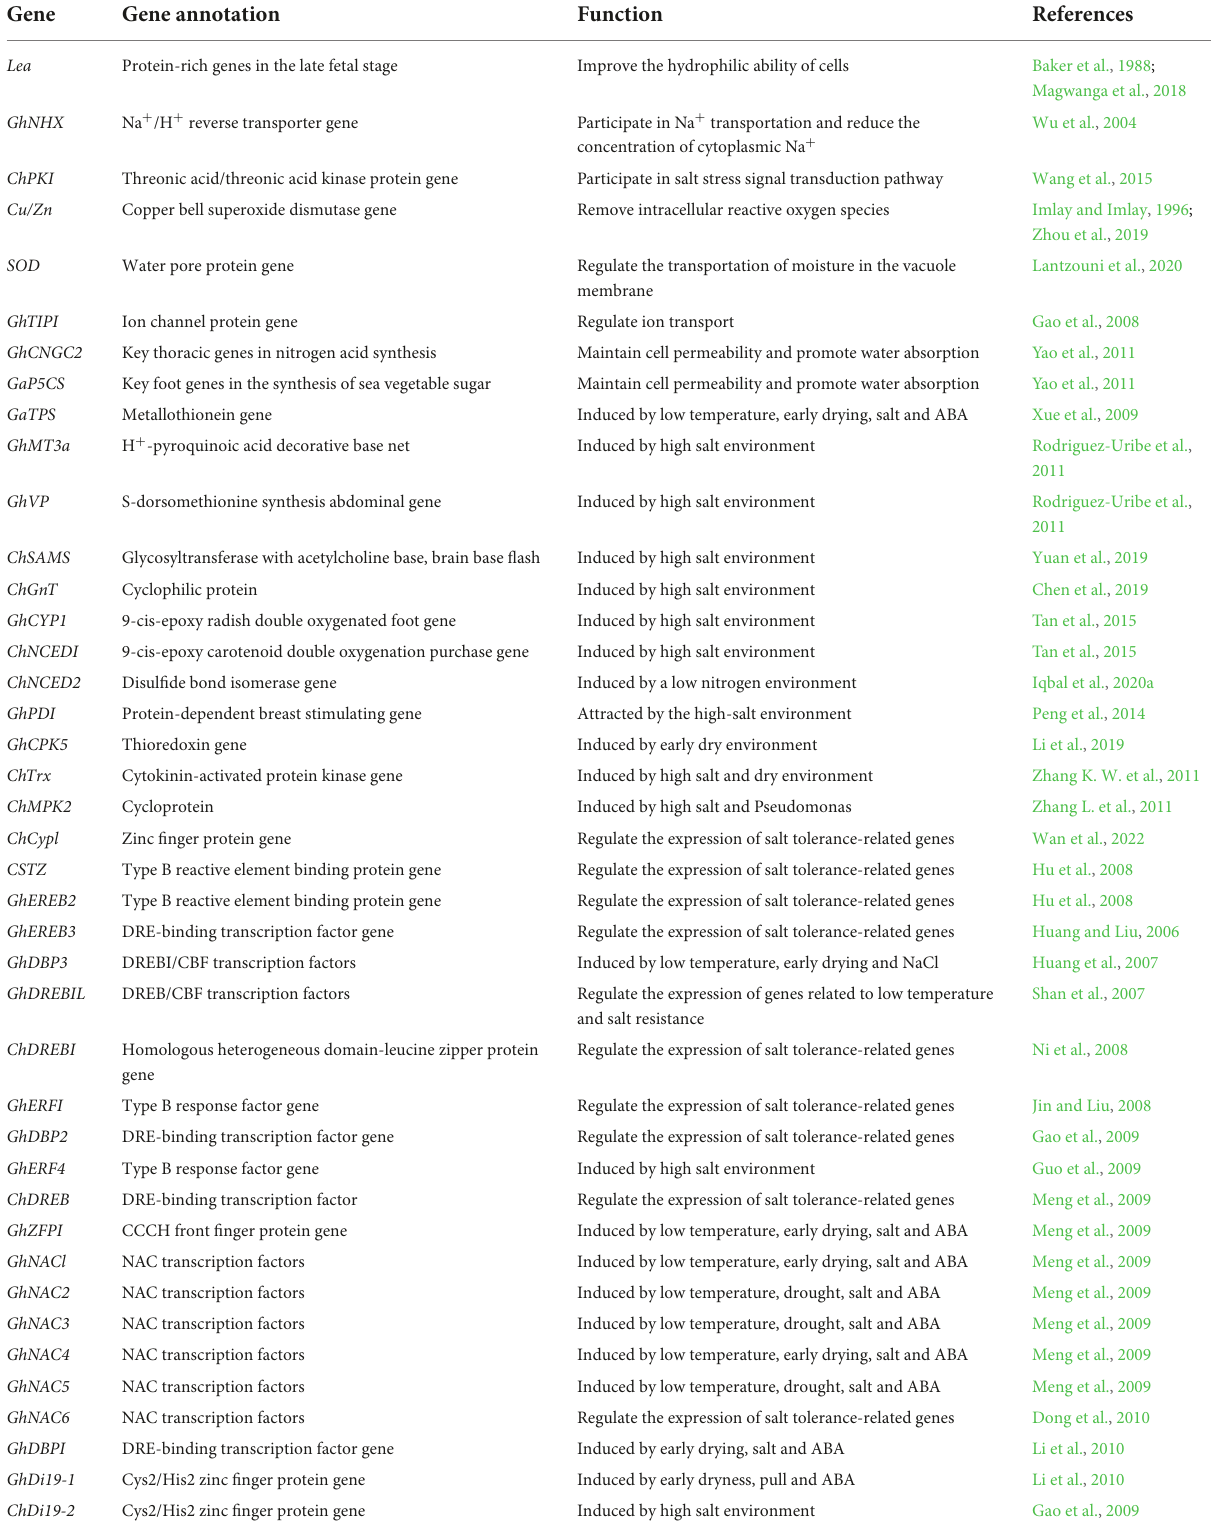
TABLE 1 Genes related to stress tolerance previously cloned in